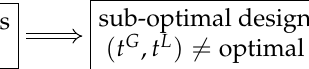
Figure 19. Sub-optimal overall